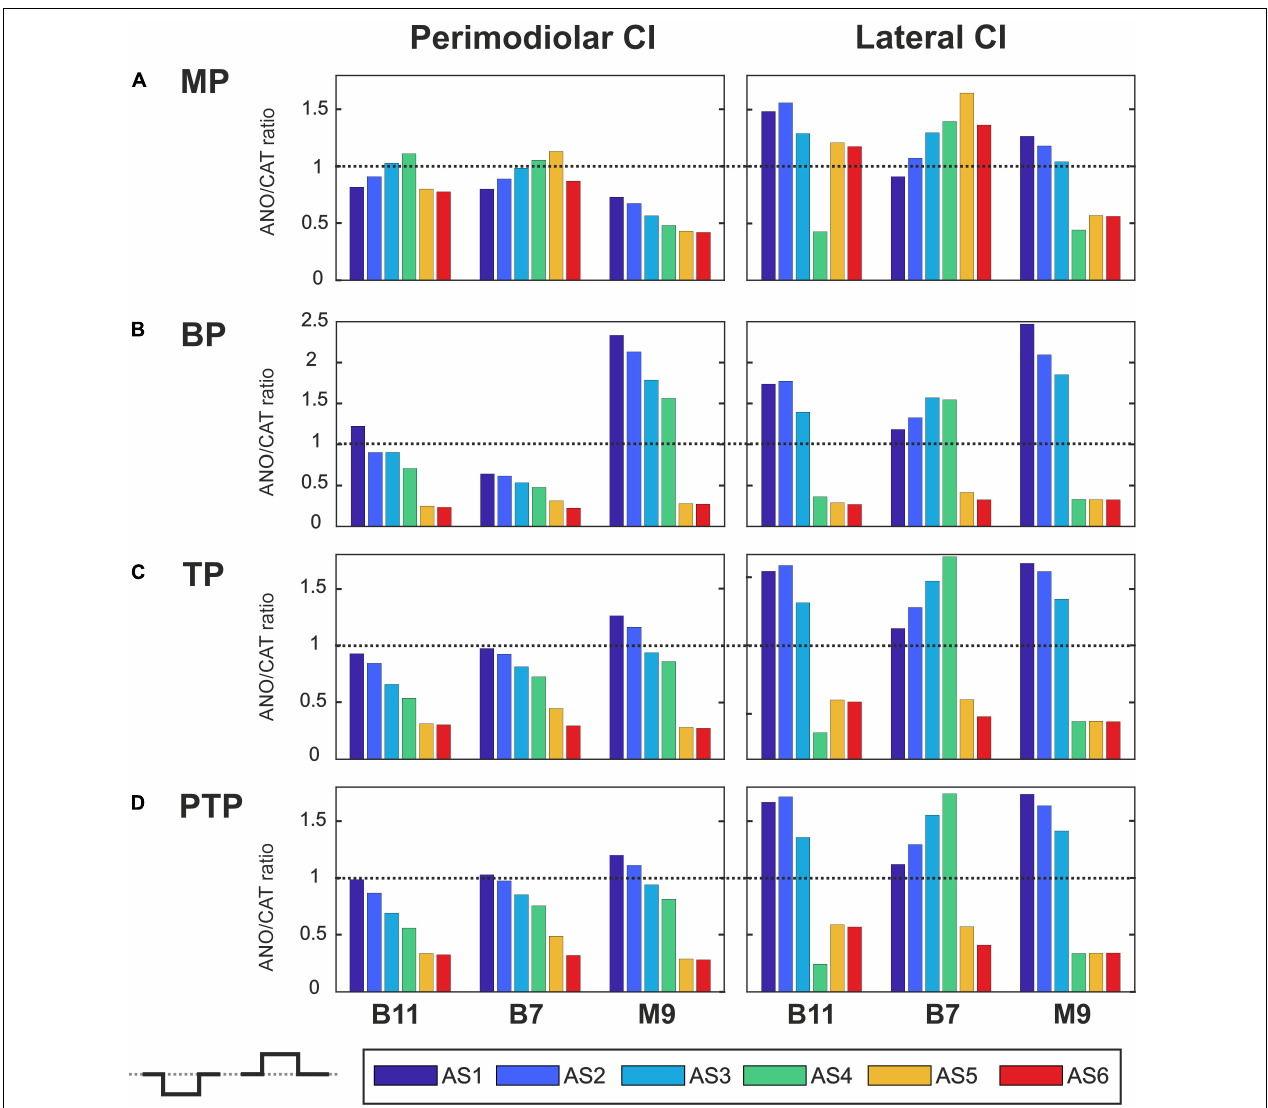
FIGURE 7 | Polarity ratios for different degeneration levels stimulated with the monophasic pulse. Threshold ratios are shown for the TNs B11, B7, and M9 with color-coded degeneration levels (A) monopolar (MP), (B) bipolar (BP), (C) tripolar (TP), (D) partial tripolar (PTP) stimulation strategies. The horizontal dotted lines indicate the polarity ratio ANO/CAT =